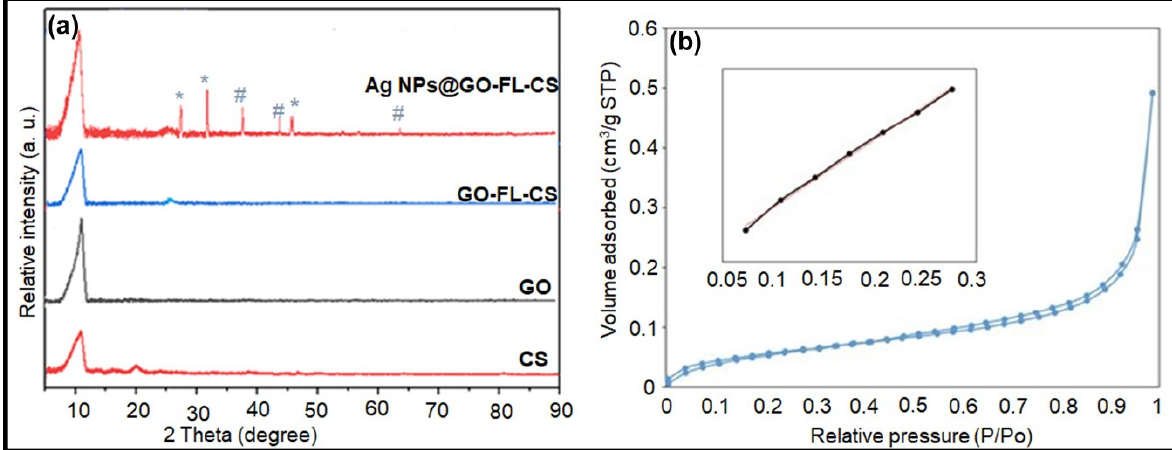
Figure 5. ( a ) XRD patterns of GO, CS, GO-FL-CS, and Ag NPs@GO-FL-CS; Peaks attributed to crystalline phase of (*) AgCl and (#) Ag NPs; ( b ) N 2 adsorption-desorption isotherms of Ag NPs@GO-FL-CS.